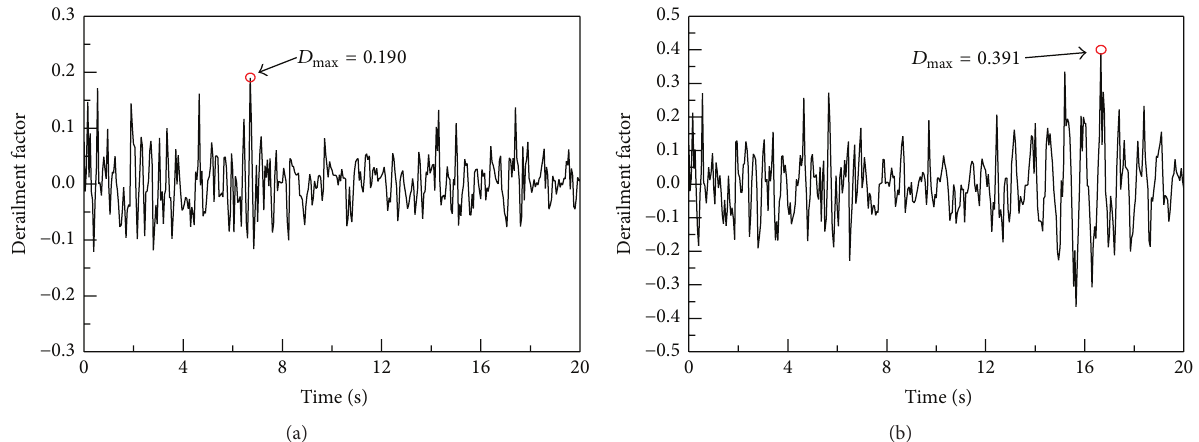
Figure 16: Derailment factor time histories comparison of the first wheel set: (a) without earthquake; (b) with earthquake.